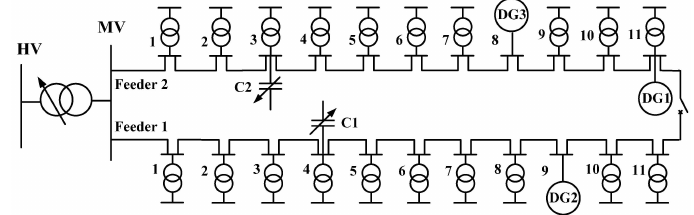
Figure 6. The single line diagram of 22-bus distribution test system.